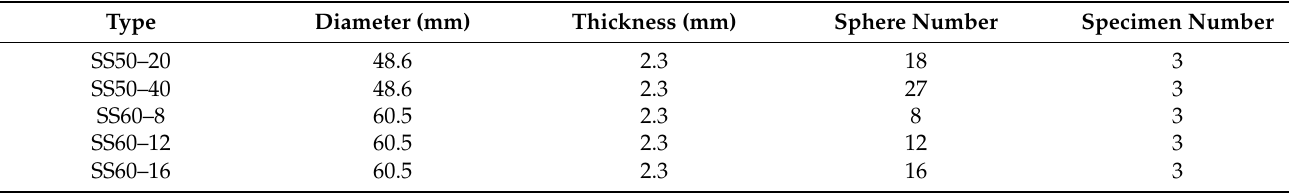
Table 1. The sphere diameters and the number of spheres.